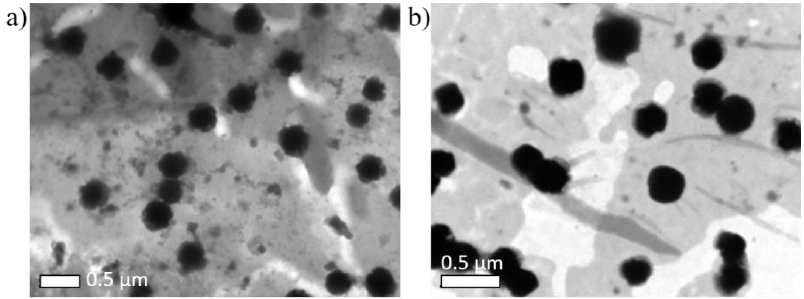
Figure 2. TEM images of the W/O microemulsions negatively stained with 1% phosphotungstic acid. Microemulsion with a composition corresponding to the formulations ( a ) 3 and ( b ) 5 in the ternary diagram of the CTAB-butanol–hexanol-water